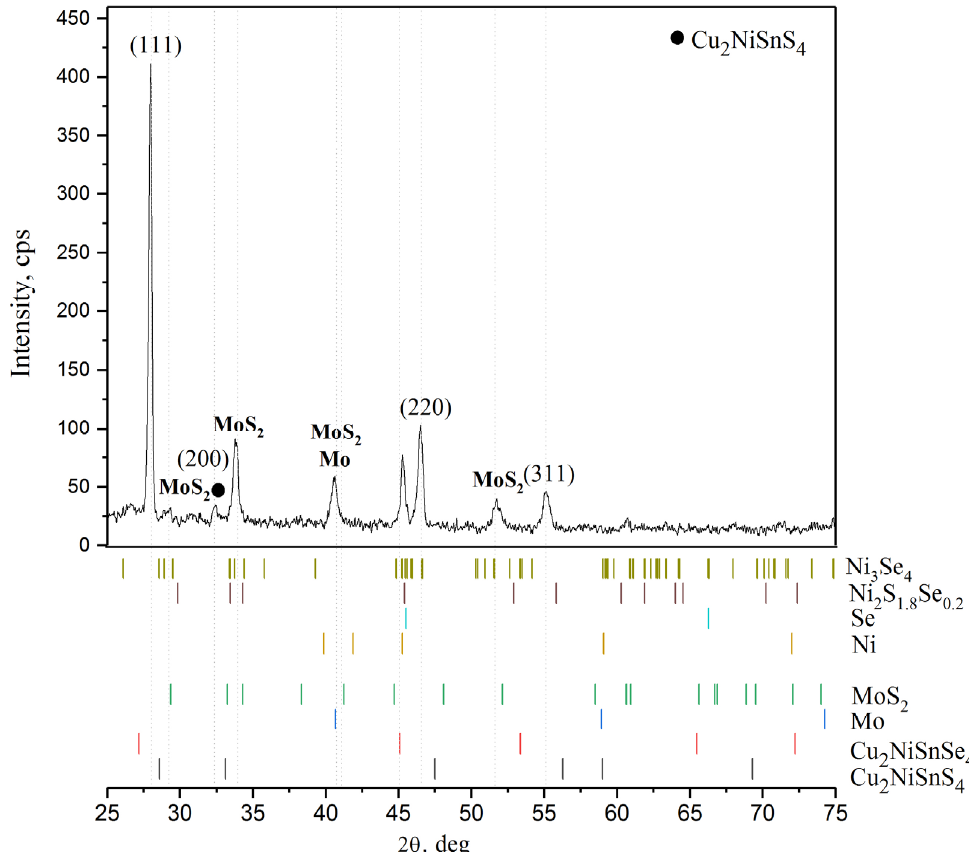
Figure 6. A typical X-ray pattern of the CNTSSe thin films on a glass/Mo substrate. Reference patterns from COD: Ni 3 Se 4 (no. 96-900-9245), Ni 2 S 1.8 Se 0.2 (no. 96-153-8792), Se (no. 96-901-3135), Ni (no. 96-901-3008), MoS 2 (no. 96-153-5541), Mo (no. 96-901-1607), Cu 2 NiSnSe 4 (no. 00-026-0551), Cu 2 NiSnS 4 (no. 00-026-0552).